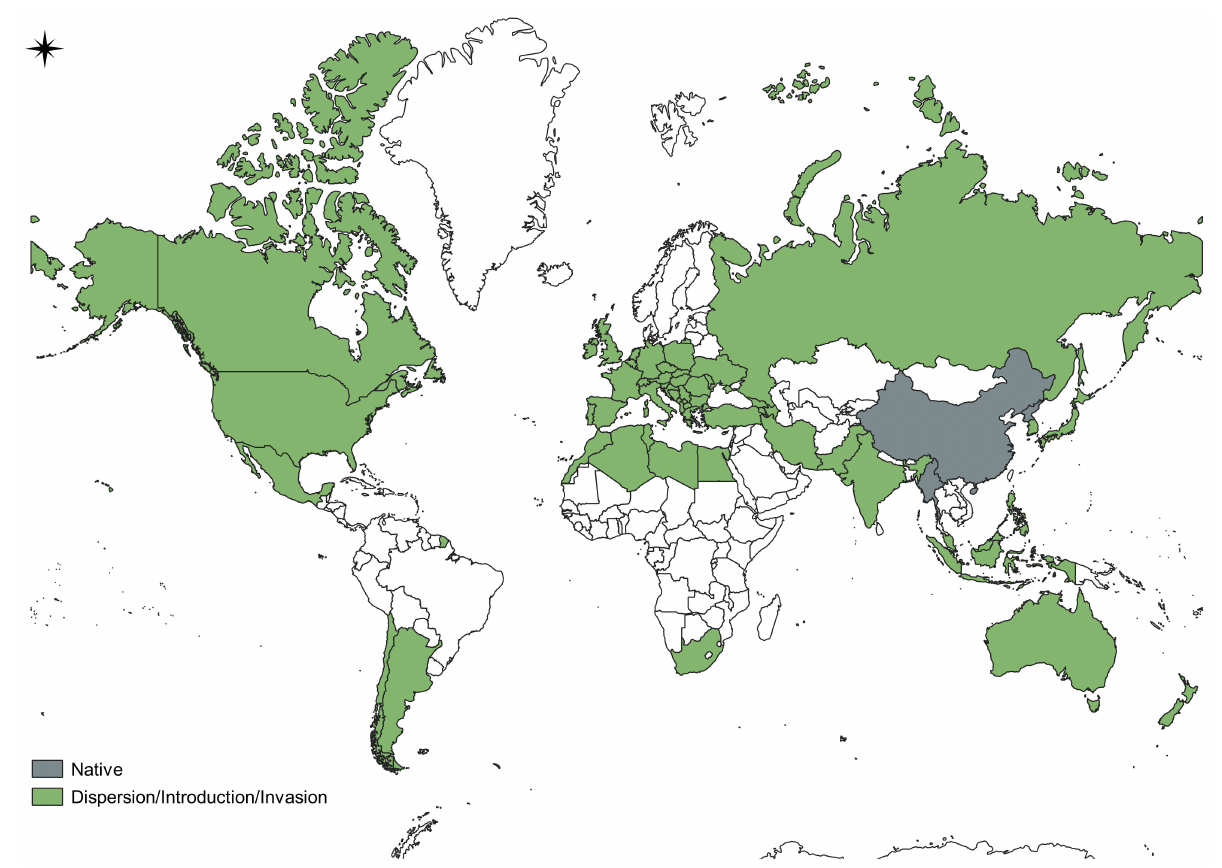
Figure 1. Countries where A. altissima has been reported as an introduced, naturalized, and invasive species (adapted from